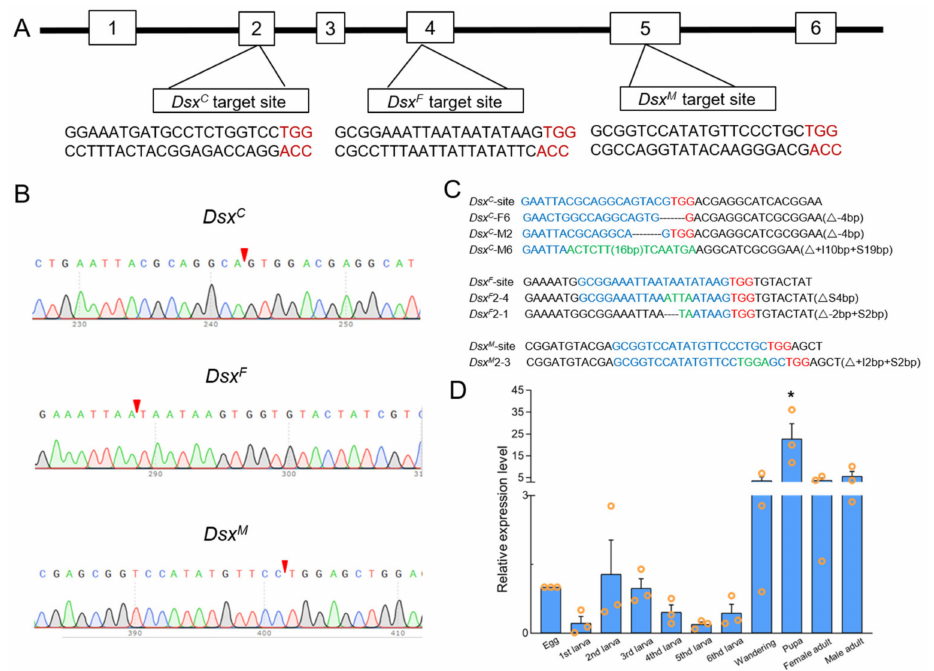
Figure 1. CRISPR/Cas9-mediated mutation within Sfdsx target sites and temporal expression of Sfdsx gene. ( A ) Target sites on exons 2, 4, and 5 to eliminate the common, female-specific, and male-specific regions of the Sfdsx gene. Red represents PAM sequences, and black represents substitutive sequences. ( B ) Sequencing chromatogram of the Sfdsx C , Sfdsx F , and Sfdsx M mutants. The red arrow refers to the position of PCR and sequencing on common, female-specific, and male-specific regions of Sfdsx by the CRISPR/Cas9 gene-editing system. ( C ) Common, female-specific, and male-specific mutants of Sfdsx detected by sequencing. The dashed lines “–” indicate deleted nucleotides relative to wildtype. The guide RNA target sequences are marked in blue. ( D ) Temporal expression of Sfdsx across different developmental stages of S. frugiperda . The internal reference is ß-actin . The asterisks (*) indicate significant differences ( p < 0. 05). Data were analyzed using Tukey’s test (one-way